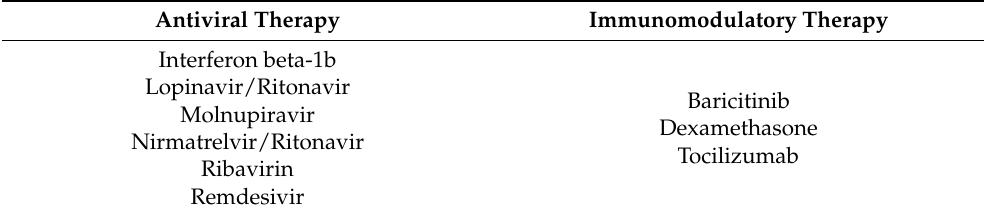
Table 1. Antiviral and immunomodulatory therapies used in Hong Kong for COVID-19.